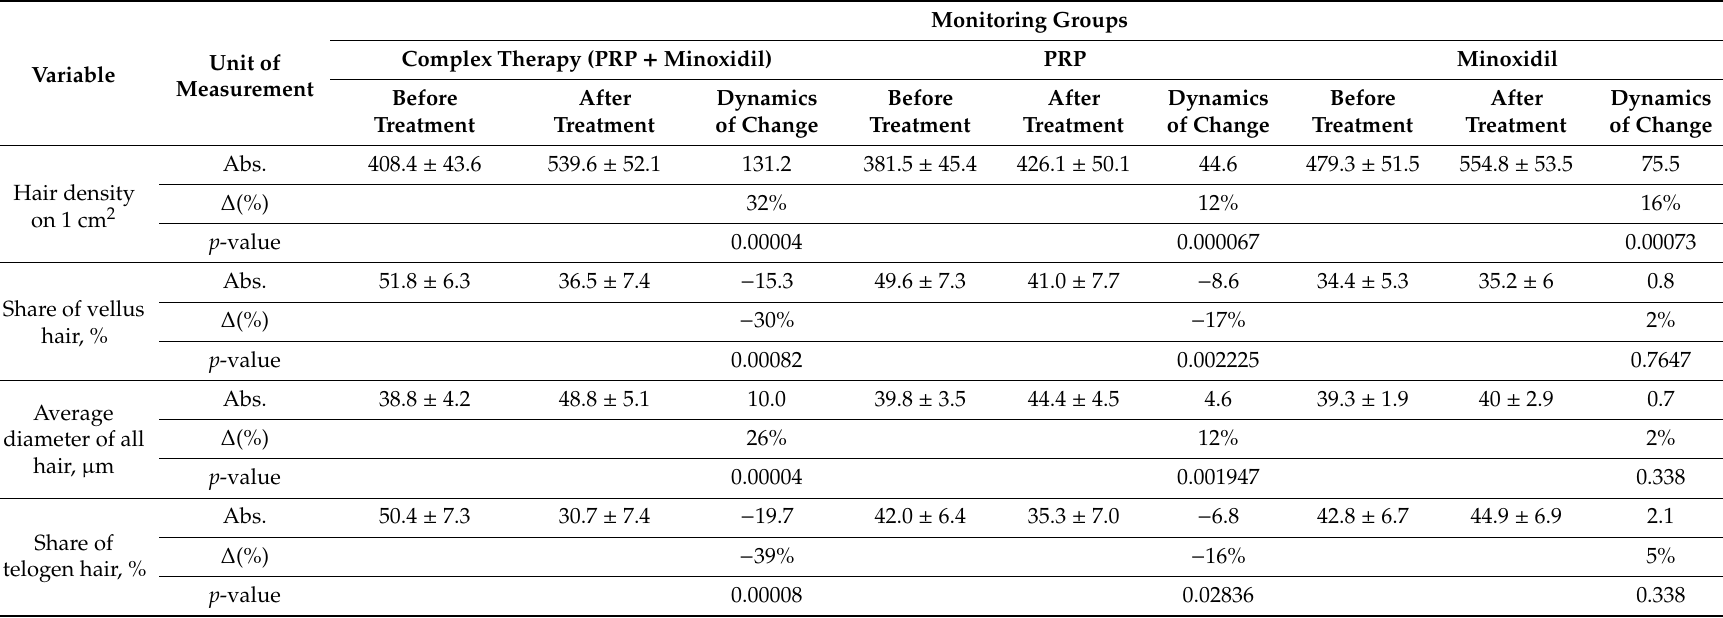
Table 1. Dynamics of morphometric indicators of hair